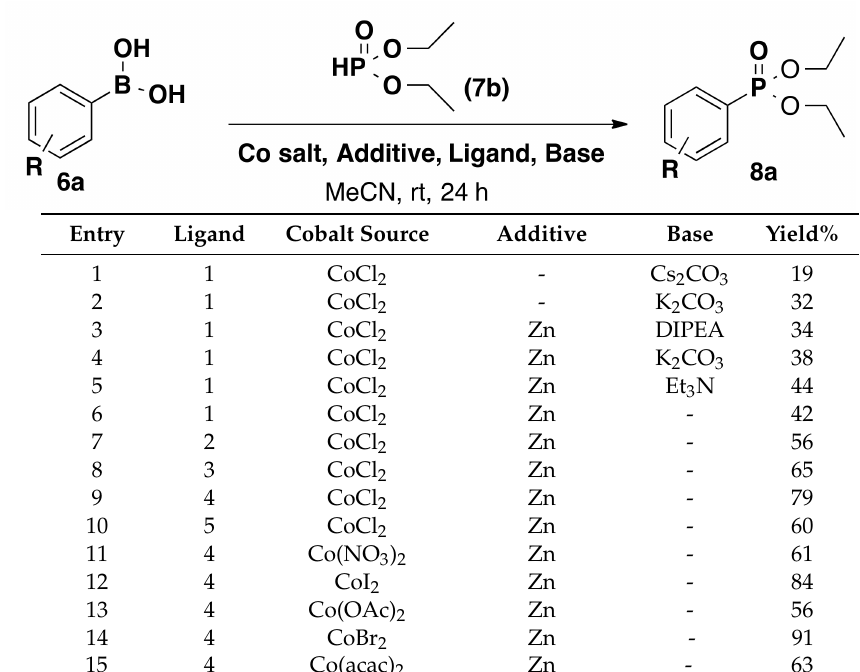
Table 1. Optimization of the reaction conditions a .